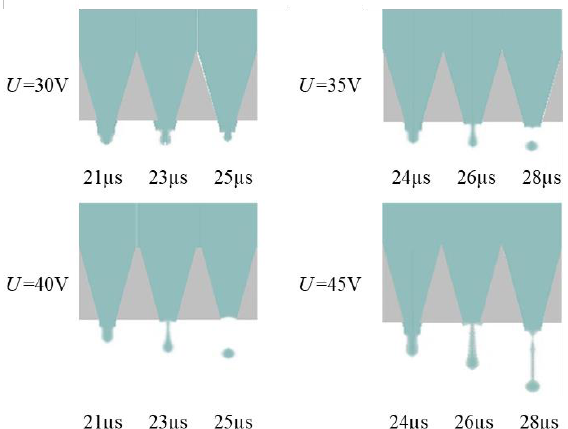
Figure 14. Simulation results of droplet formation at the nozzle at different U.